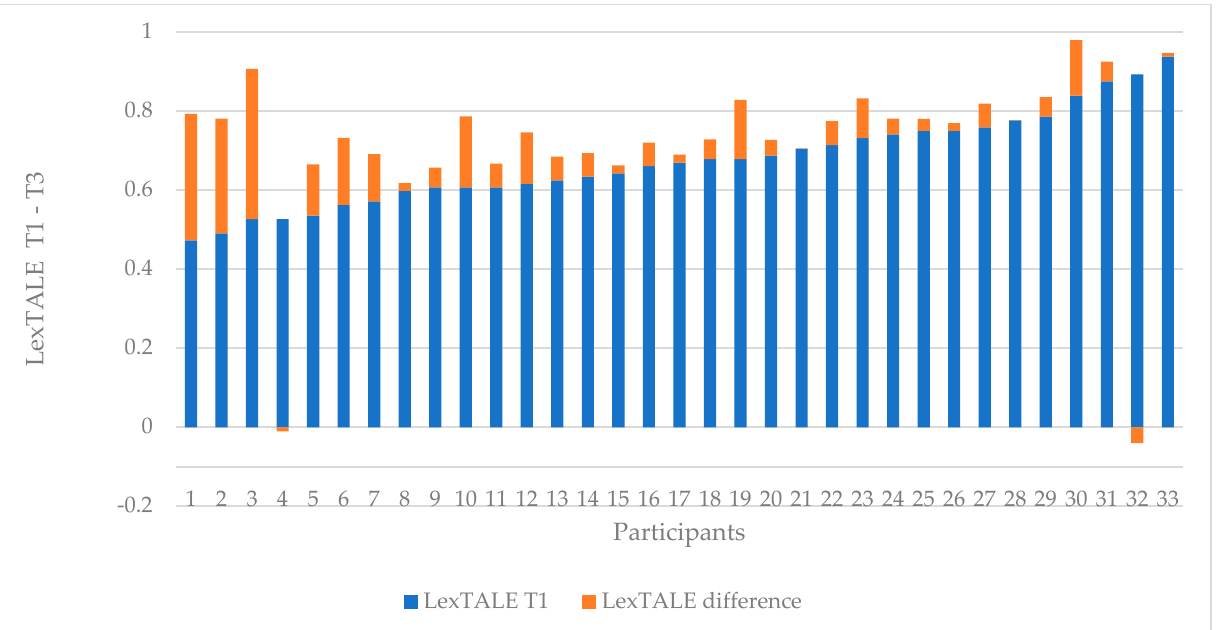
Figure 2. Changes in actual proficiency before and after the SA period, sorted according to the score at Time 1.